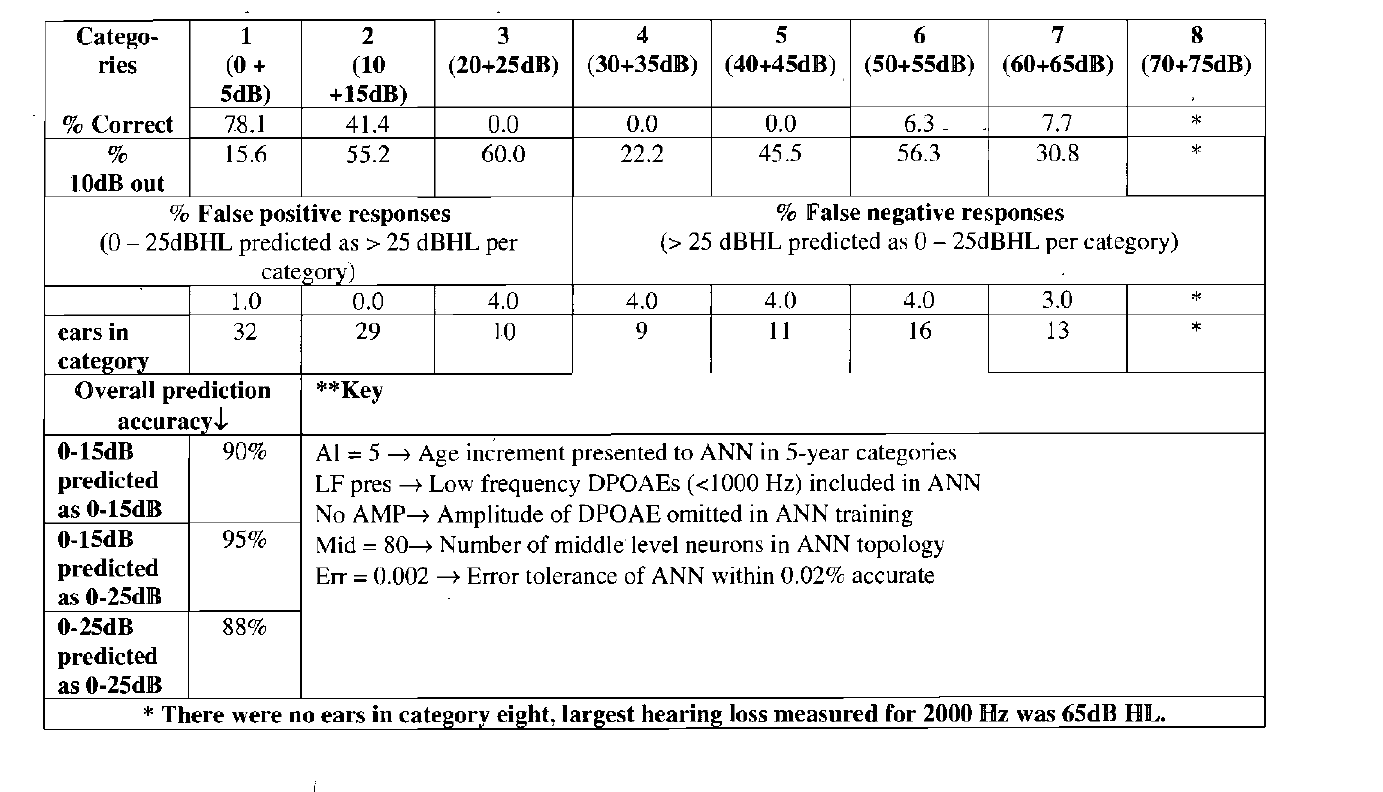
Table 5: Prediction of 4000 Hz with Al = 5, LF pres, Mid = 80, Err = 0.002, No